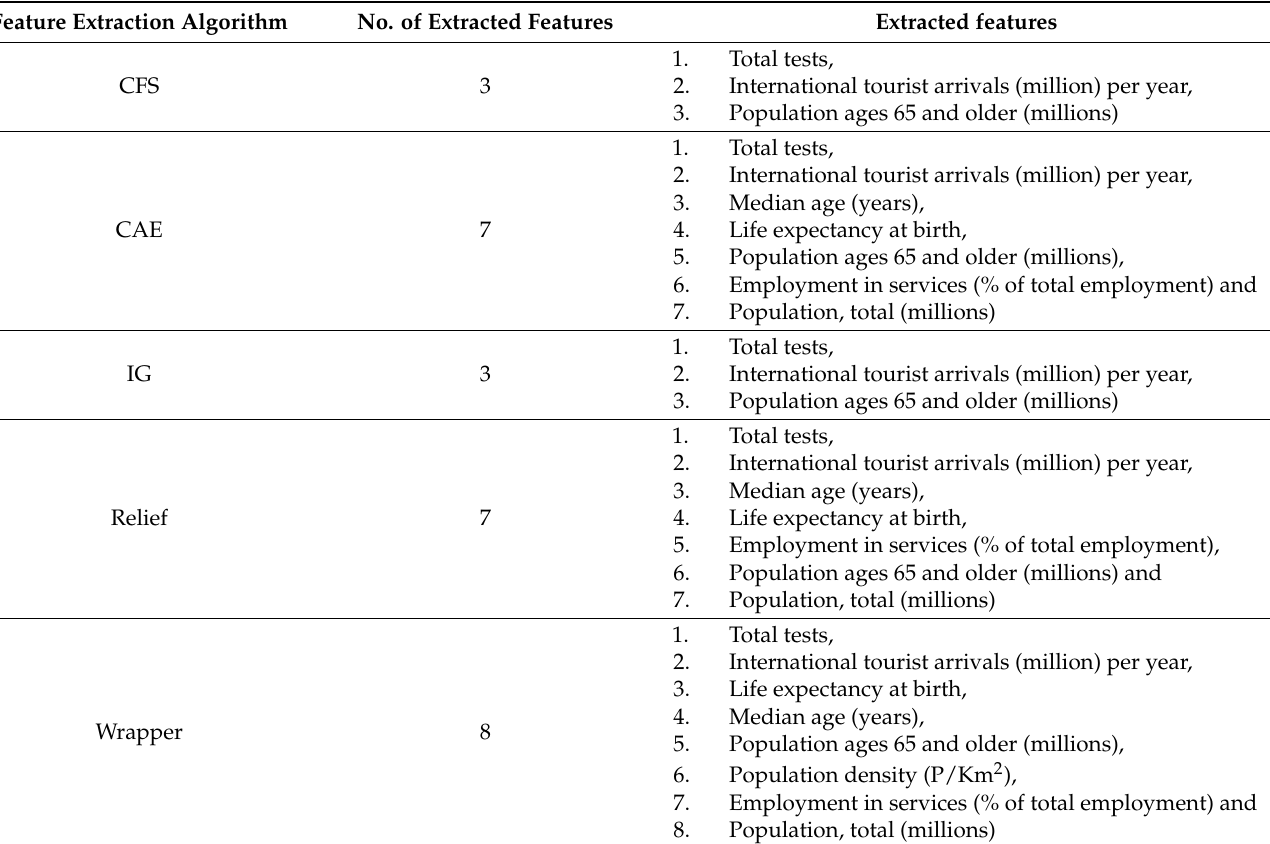
Table 11. The ranked features of the feature extraction algorithms to predict the total infected